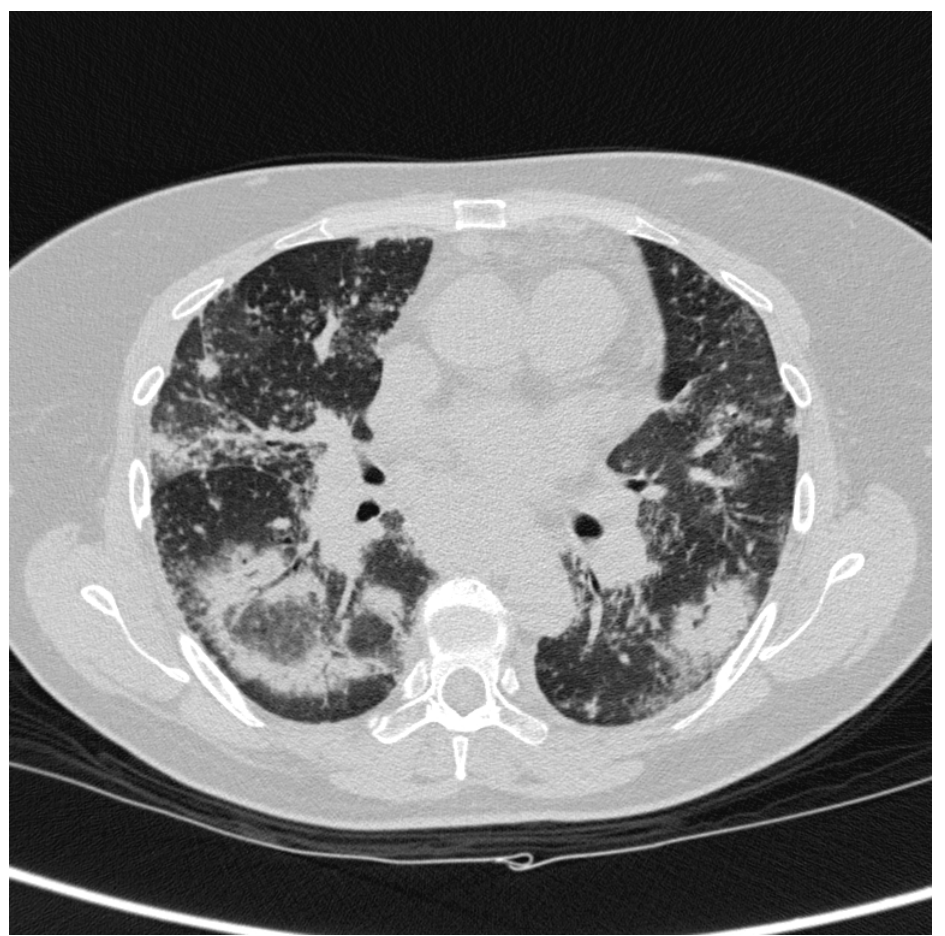
Figure 5. A patient affected by sarcoidosis (biopsy-proven). Axial scan in lung windows settings shows an area of ground-glass opacities (GGO) surrounded by denser consolidation of crescentic shape. This particular conformation is known as reverse halo sign or atoll sign.